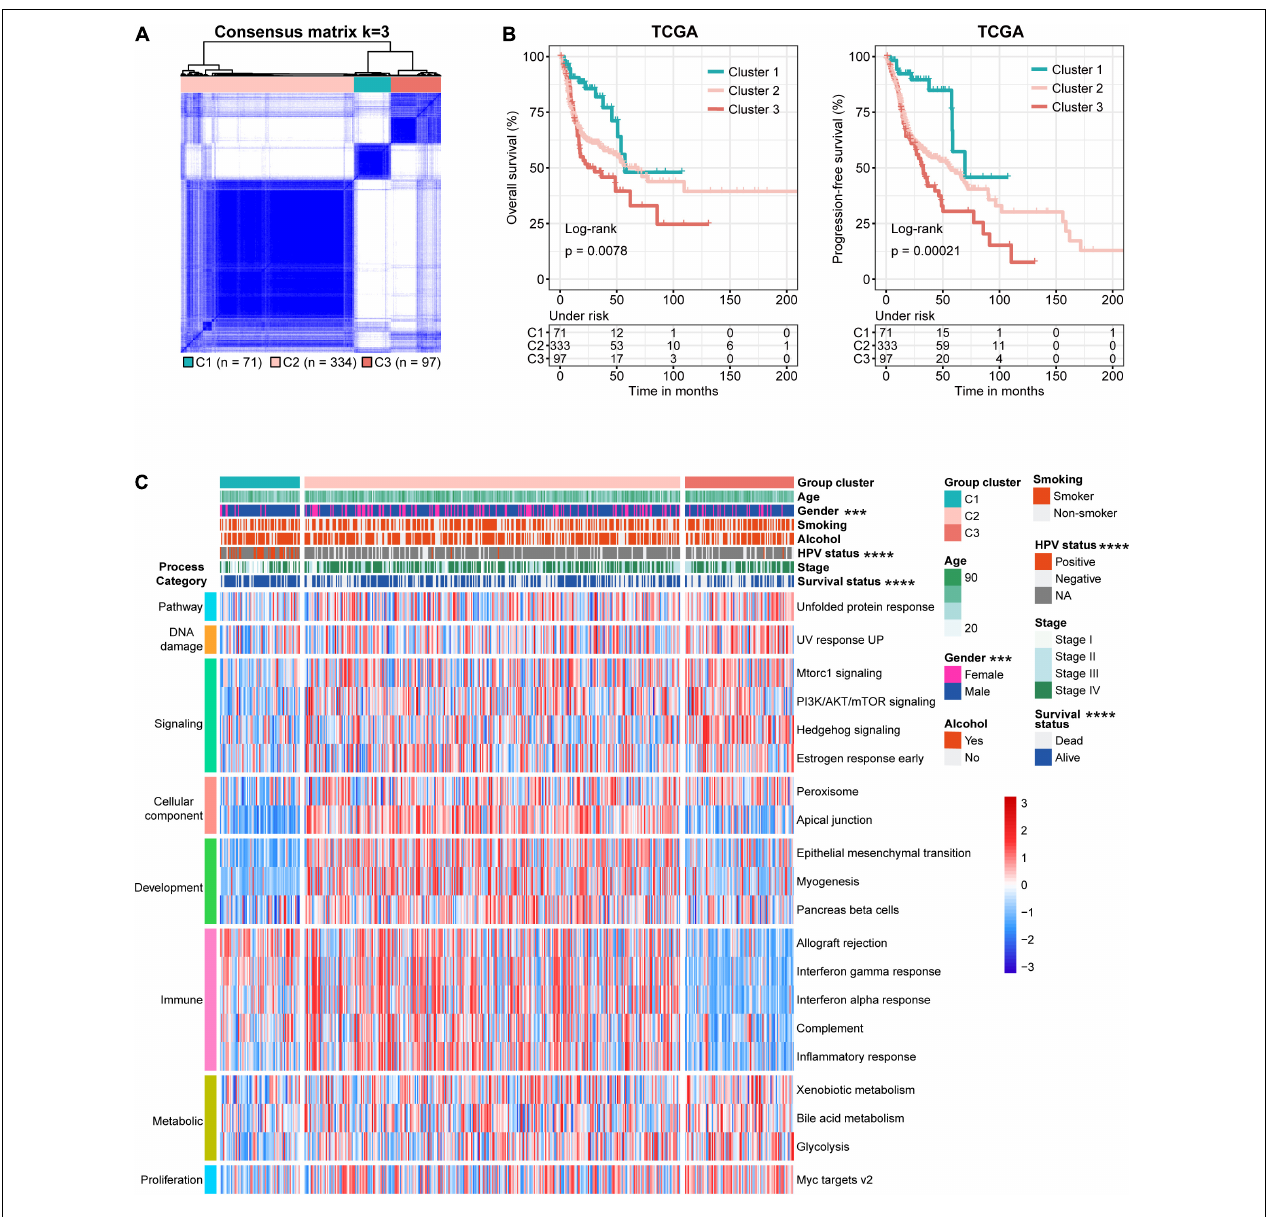
FIGURE 3 | Identification of three molecular subtypes of head and neck squamous cell carcinoma (HNSCC) in The Cancer Genome Atlas (TCGA) discovery dataset. (A) Consensus matrix heatmaps ( k = 3) of common core genes in The Cancer Genome Atlas (TCGA) cohort. (B) Kaplan–Meier curves of overall (left, OS) and progression-free (right, PFS) survival for HNSCC patients in different subtypes. (C) Heatmap of differentially activated pathways based on gene set variation analysis (GSVA) score and clinicopathological features of the three